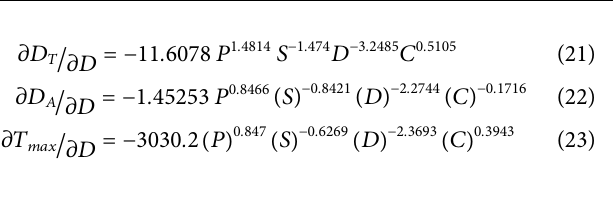
Frontiers in Materials |